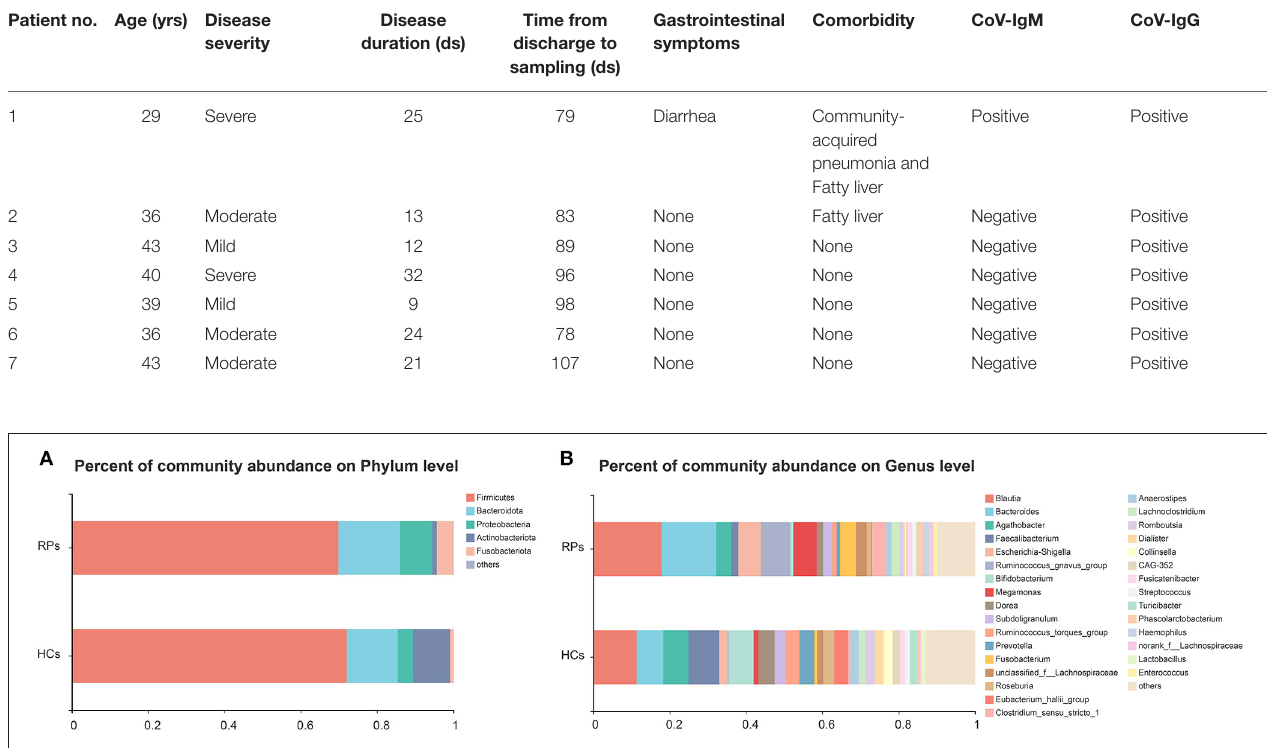
FIGURE 1 | The relative abundance of gut microbiota at the Phylum (A) and Genus (B) levels in the healthy control group and the recovered COVID-19 patient group. The category “Other” covers all other phyla or genera with a low taxa abundance. RPs, recovered patients; HCs, healthy